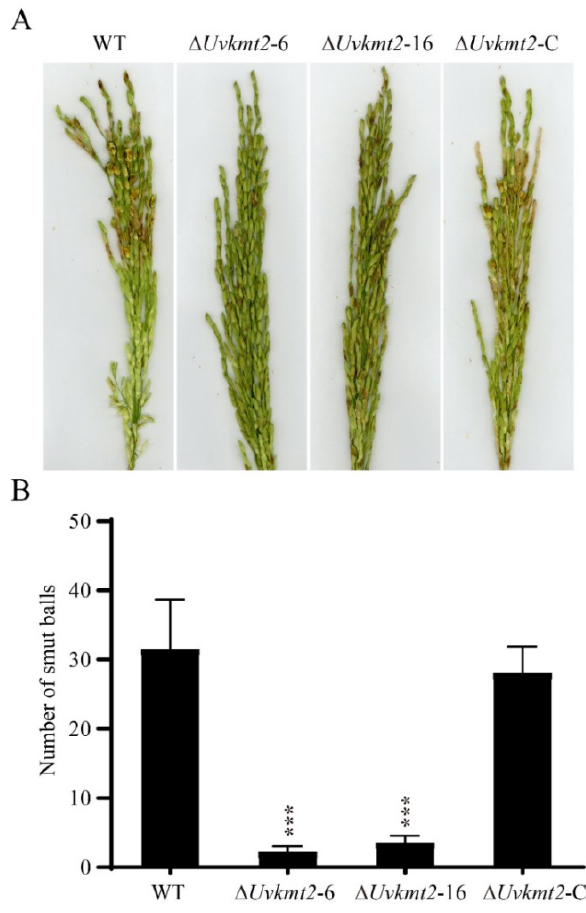
Figure 4. Deletion of UvKMT2 gene resulted in reduced virulence. ( A ) Virulence assays of the WT, ∆ Uvkmt2 , and complemented strains. The conidia from indicated strains were injected into the panicles of rice plants ( Oryza sativa L., cultivar Wanxian 98) at booting stage. The photos were taken at 21 dpi (days post inoculation). ( B ) The false smut balls inoculated with the Δ Uvkmt2 strain were fewer than those of the WT and complemented strains. At least three independent biological experiments were performed with 30 inoculated panicles each time. Error bars represent the standard deviations. The data were subjected to Duncan’s test, and the significant differences were indicated by asterisks (***, p <